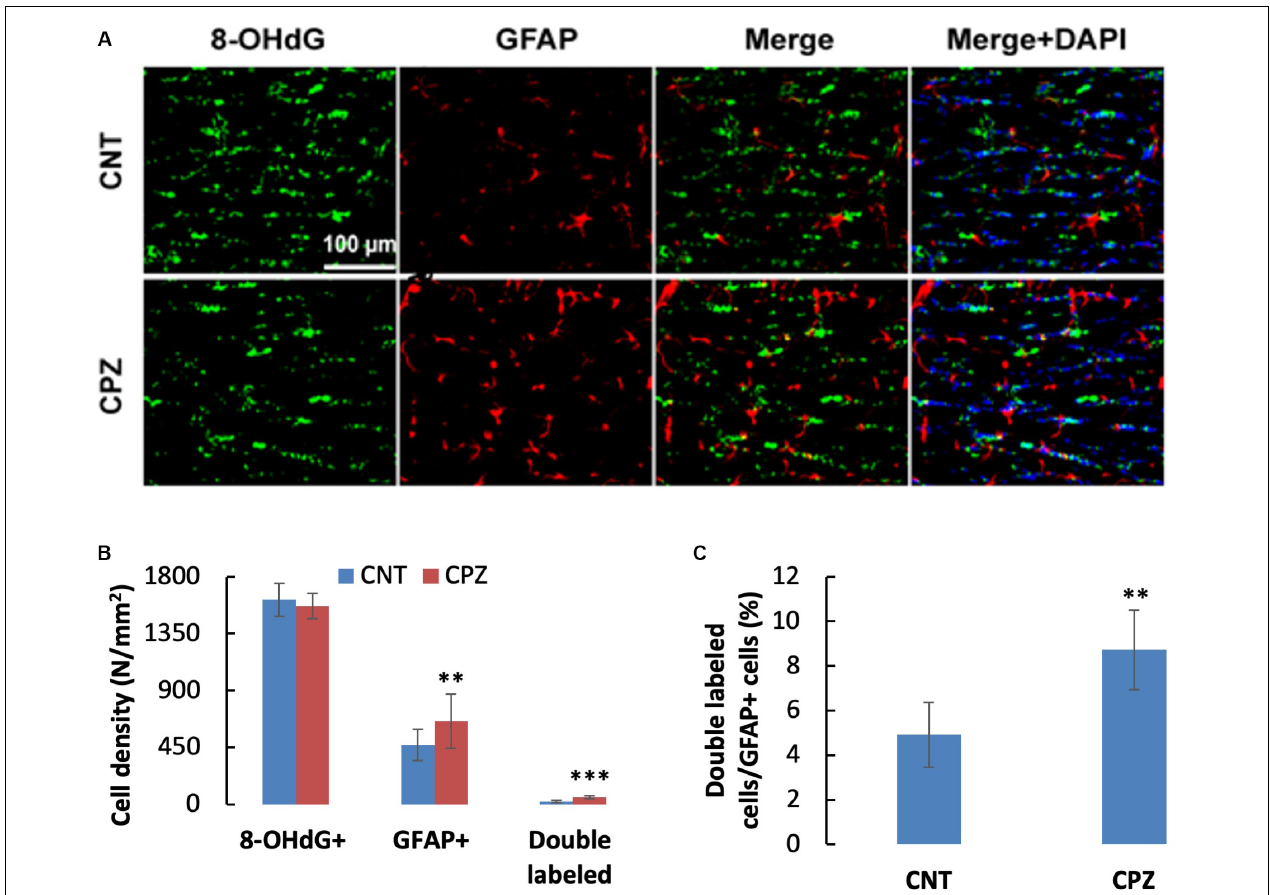
FIGURE 3 | (A) Representative photographs showing cells labeled by the antibody to 8-OHdG, antibody to GFAP, and double labeled cells by the two antibodies. (B,C) Bar charts showing the statistical analysis results of the immunofluorescent staining. Data are expressed as means ± SD ( n = 6/group). ** p < 0.01, *** p < 0.0001. The comparisons were made between CNT and CPZ groups by performing t -test or chi-square test (percentage of double labeled cells in GFAP + cells).